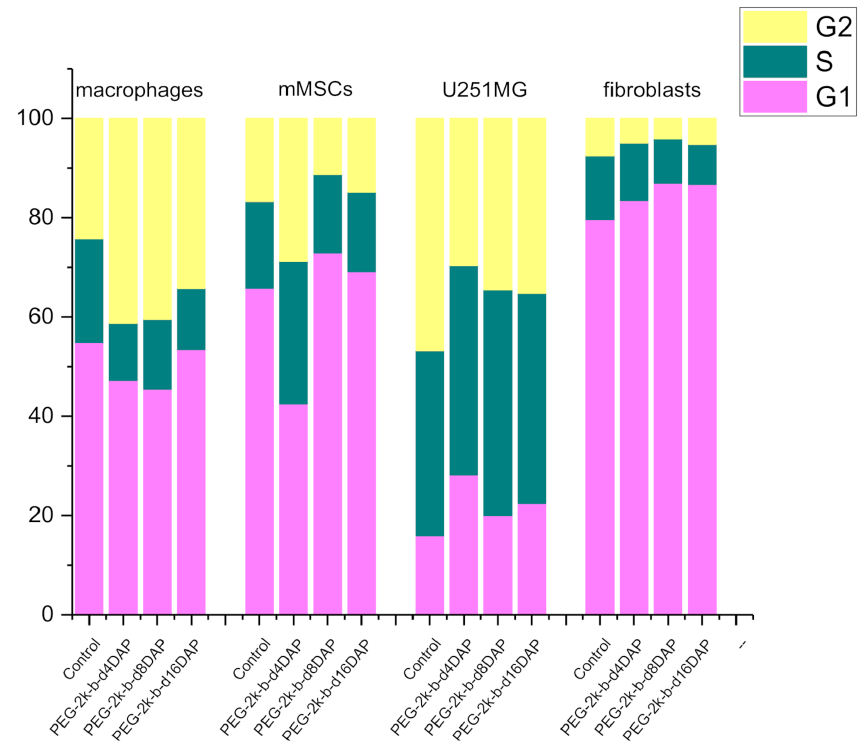
Figure 6. Cell cycle population distribution (percentage of cells, %) after treatment for 24 h with PEG 2k - b -dxDAP aggregates obtained by microfluidics (A, Table 3) and with a polymer concentration adjusted to 0.4 mg mL − 1